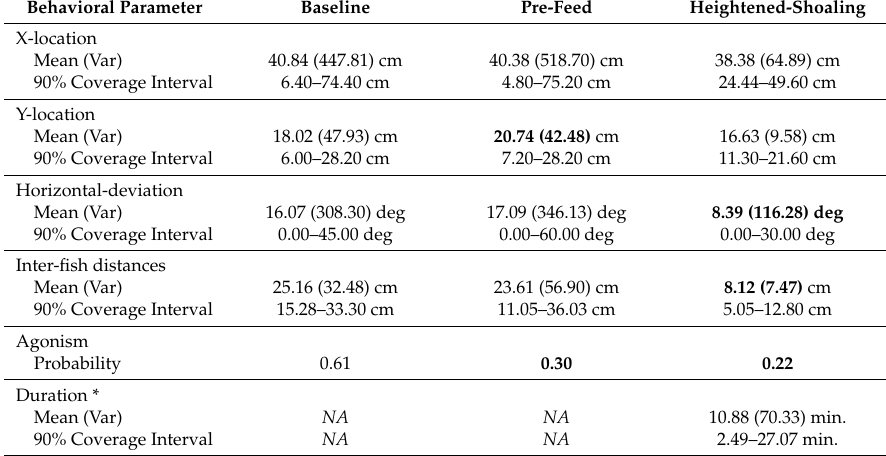
Table 1. Summary statistics. Zebrafish were observed in naturalistic tanks over a 6-month period ( n = 6 tanks, 10 zebrafish per tank), with 4 days selected for scan-sampling (producing 180, 180, and 90 scan-sample observation periods for the baseline, pre-feed, and heightened-shoaling periods respectively) and 10 days selected for all-occurrence-sampling (producing 31 heightened shoaling episodes for analyses). X-location and Y-location measured with the origin (0, 0) at the bottom left-hand corner of the tank. Bold font indicates significantly different than baseline (multilevel models controlling for repeated sampling of tanks and days, see statistical methods for more details). * Duration was the only behavior collected using all-occurrence sampling methodology and not applicable (NA) to the baseline and pre-feed periods; all other behaviors were collected using scan-sampling